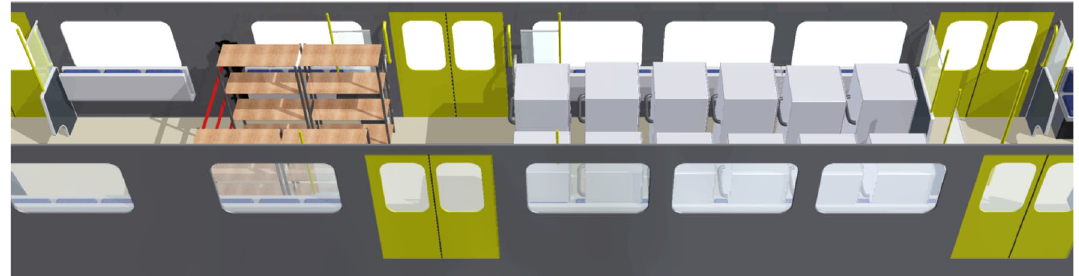
Fig. 13 Model showing the positioning of portable shelving on board the